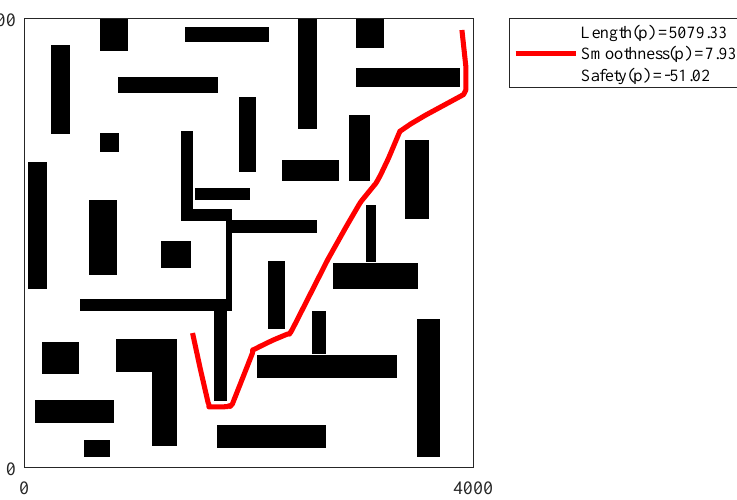
Figure 28. Path of the knee point generated via NSGA-II for Figure